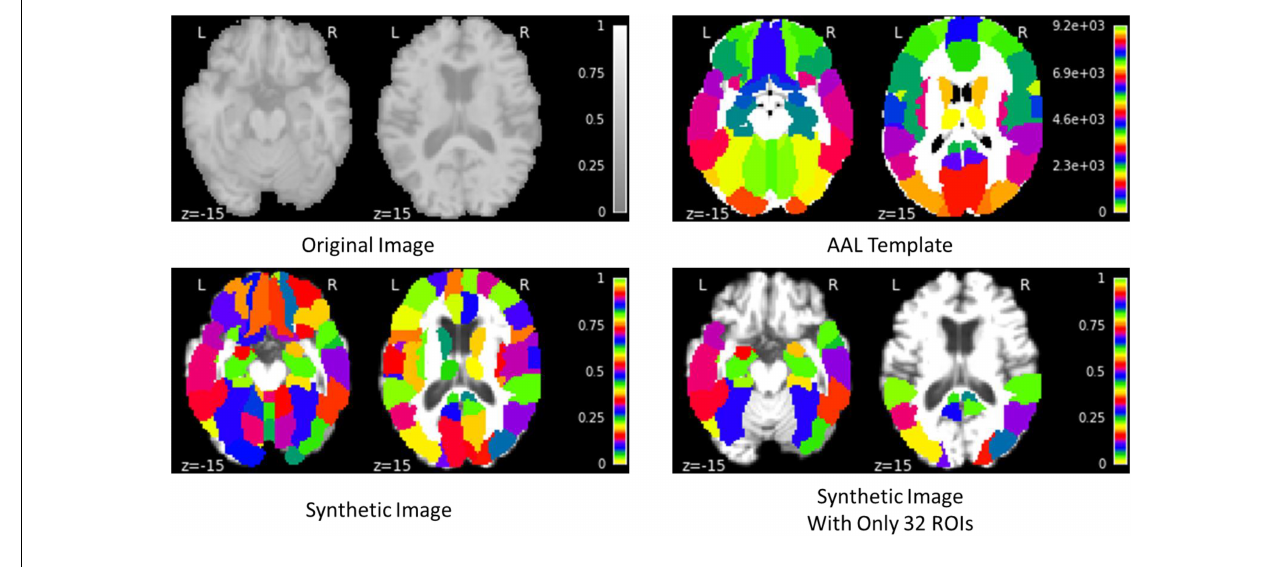
FIGURE 3 | Example of generating the synthetic MRI image.